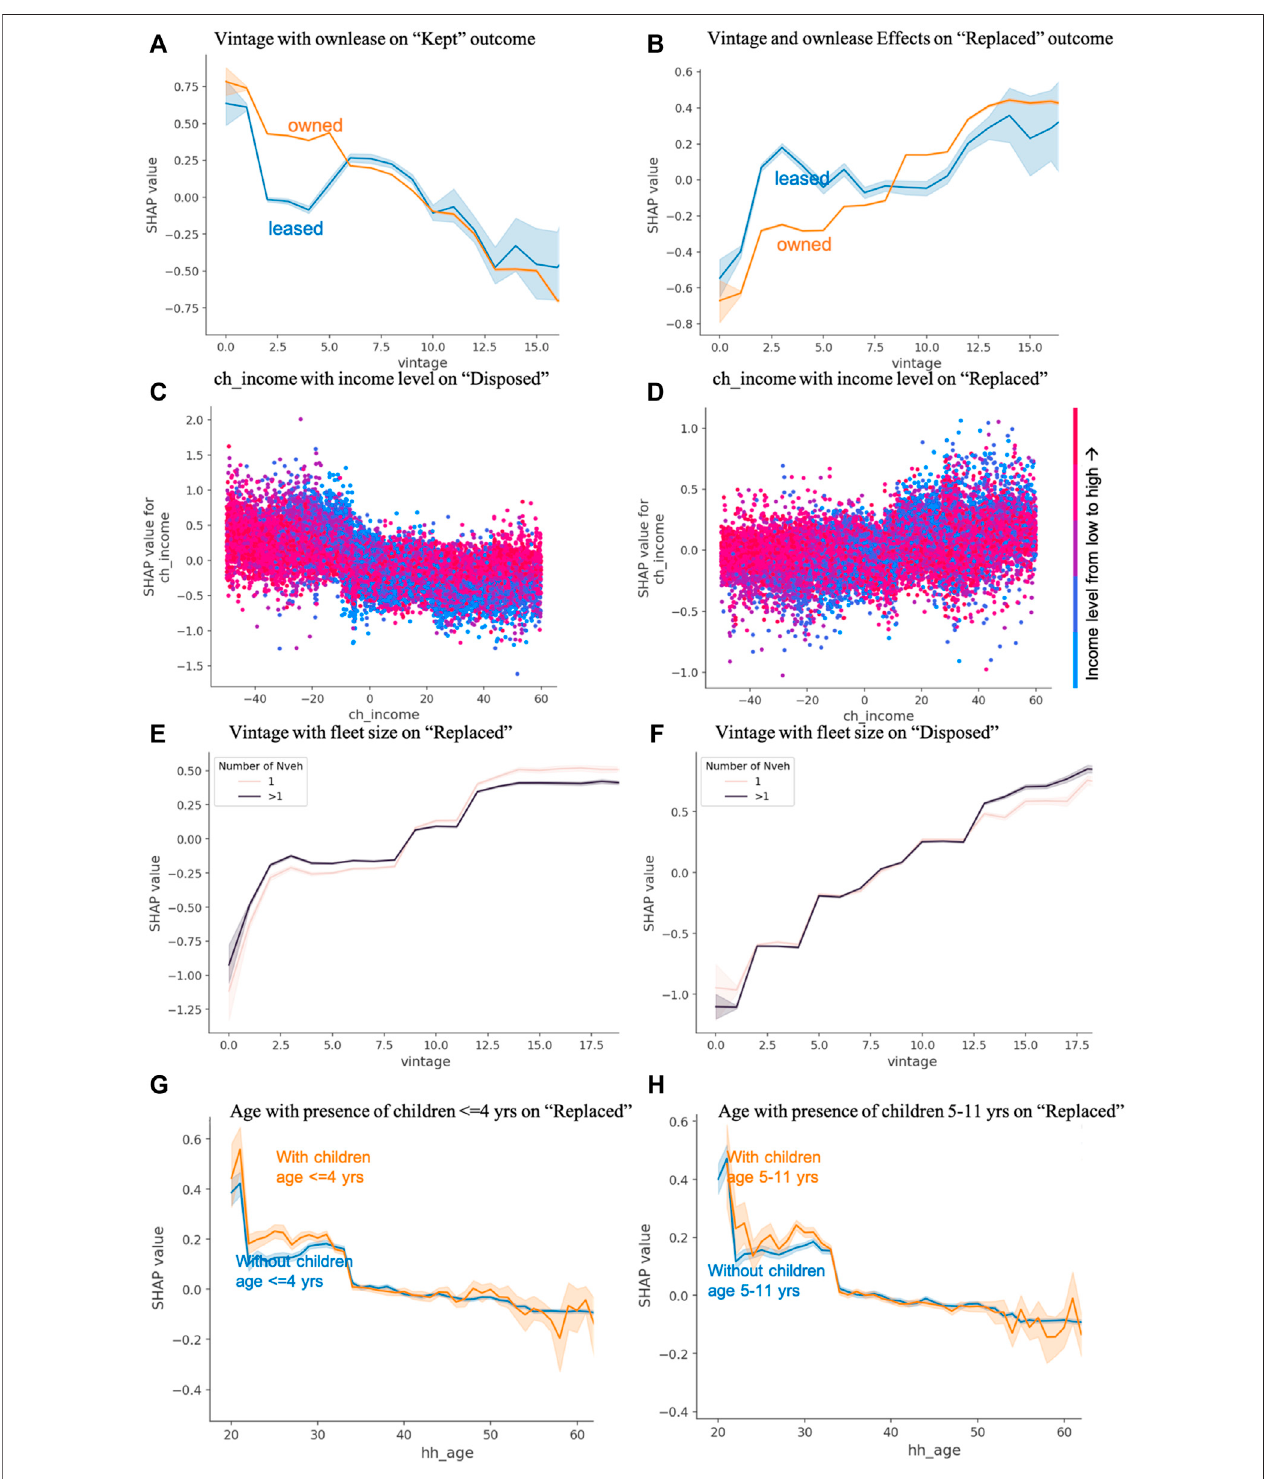
FIGURE 4 | SHAP dependence plots to illustrate effects of individual variables and their interactions on the transaction outcomes: effects of vehicle vintage and its interactionwiththeownershiptype(ownedorleased)onthelikelihoodof (A) “ kept ” outcome,and (B) “ replaced ” outcome;effectsofchangeofincomeanditsinteraction withtheincomelevels on thelikelihoodof (C) “ disposed ” outcome,and (D) “ replaced ” outcome; effects ofvintage and its interactionwith thehousehold fl eet sizeon the likelihood of (E) “ replaced ” outcome, and (F) “ disposed ” outcome; effects of household head or spouse age and its interaction with (G) presence of children of age ≤ 4 years, and (H) presence of children of age 5 – 11 years, on “ replaced ” outcome.